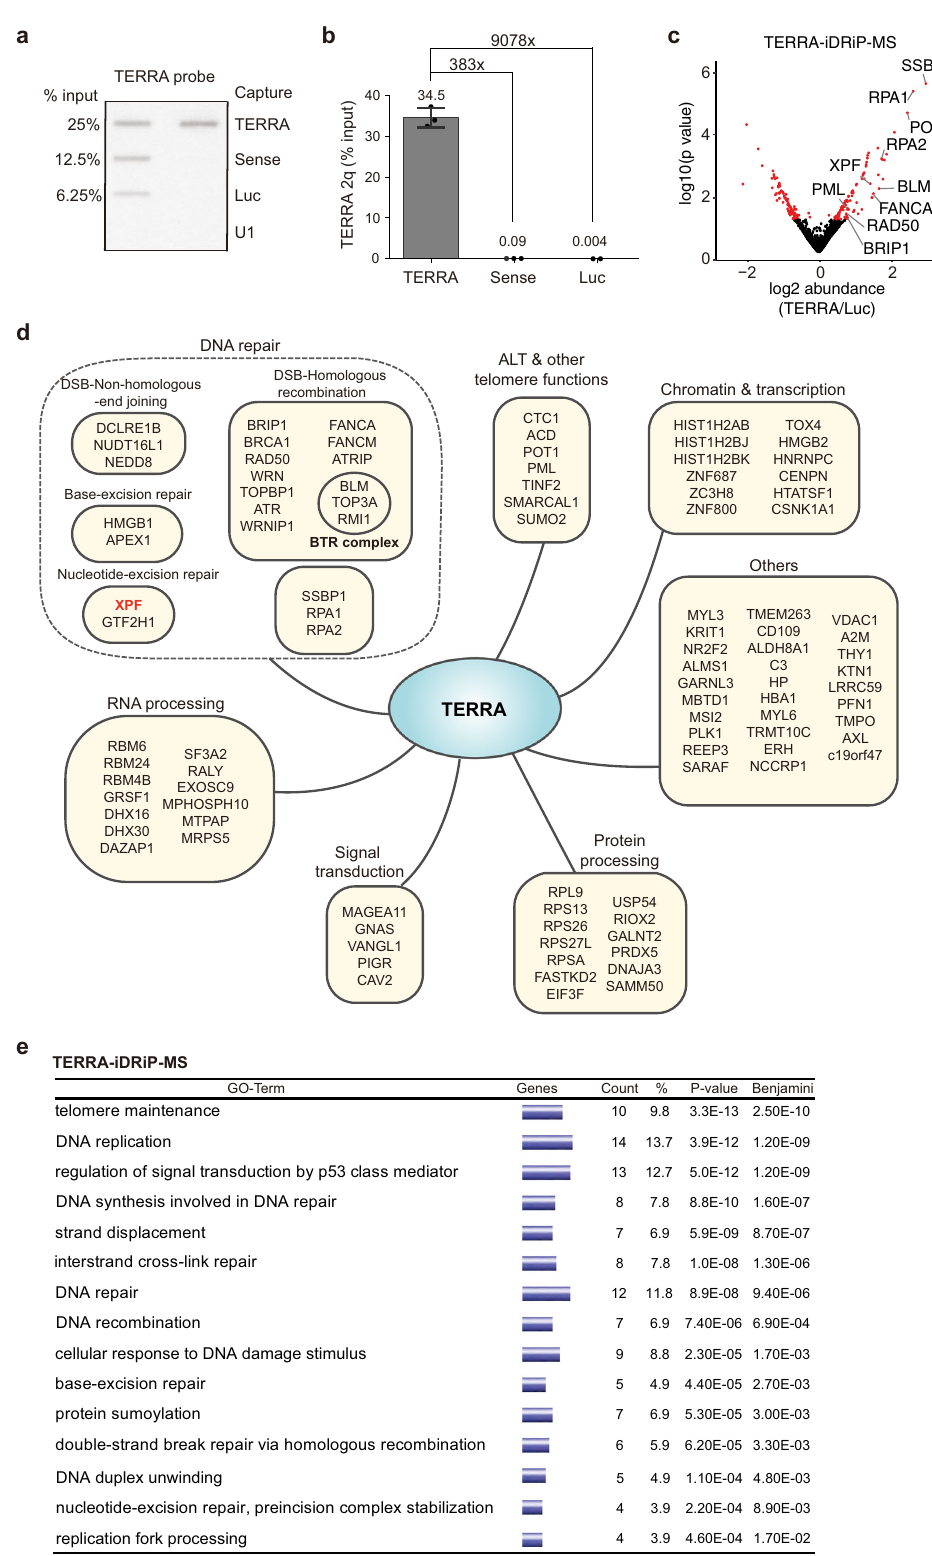
Fig.3|TERRAinteractswithDNArepairproteinsinALTcancercells.a RNAslot blotting shows the enrichment of TERRA RNA after iDRiP capture in U2OS cells. Two independent experiments show similar results. b Quanti fi cation of TERRA derivedfromchromosome2qbyqRT-PCR.Bars,mean±SD.Representativeoffour independentexperiments. c Volcano plot showing proteome abundance ofTERRA iDRiP-MSnormalizedwithluciferaseiDRiP-MS. P -valuescalculatedbyRankProduct